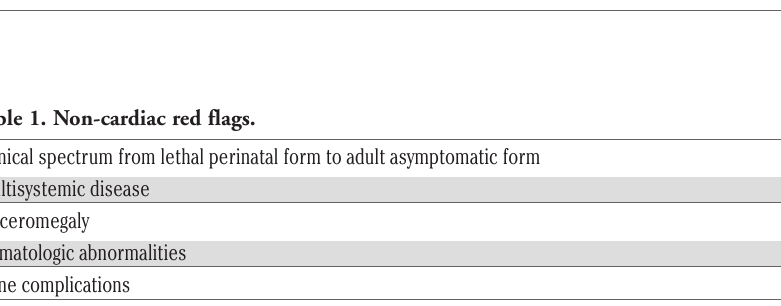
Figure 1. Bone marrow smear: Gaucher cell. The characteristic cytoplasm with striated pattern resembling wrinkled tissue paper or crumpled silk results from accumulation of glucocerebroside.